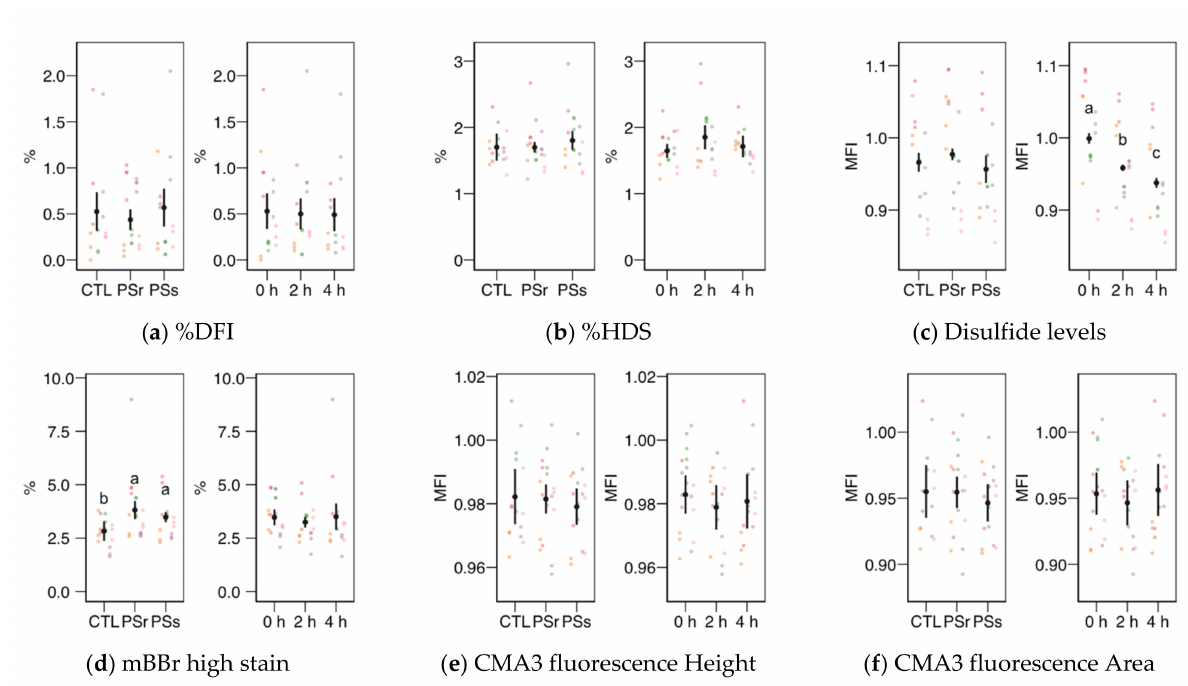
Figure 5. Sperm chromatin structure variables obtained by flow cytometry (mean ± CI95% with individual observations as dots, n = 6) during the incubation (4 h at 37 ◦ C) of thawed boar spermatozoa with seminal plasma from boars whose spermatozoa were resistant or sensitive to the cold-shock (PSr and PSs) or incubated with just MR-A (control, CTL). ( a ) Pro- portion of spermatozoa with high DNA fragmentation index (DFI) from SCSA. ( b ) Proportion of spermatozoa with high DNA stainability from SCSA. ( c ) Disulfide bridge levels according to the monobromobimane (mBBr) stain. ( d ) Proportion of spermatozoa with high mBBr fluorescence levels. ( e ) Chromomycine A3 (CMA3) fluorescence levels according to the height of the signal. ( f ) CMA3 fluorescence levels according to the area of the signal. MFI: Median fluorescence intensity. Since no interactions were significant, we show the results of the seminal plasma and incubation treatments separately as main effects. Different letters show significant differences among treatments or times ( p <